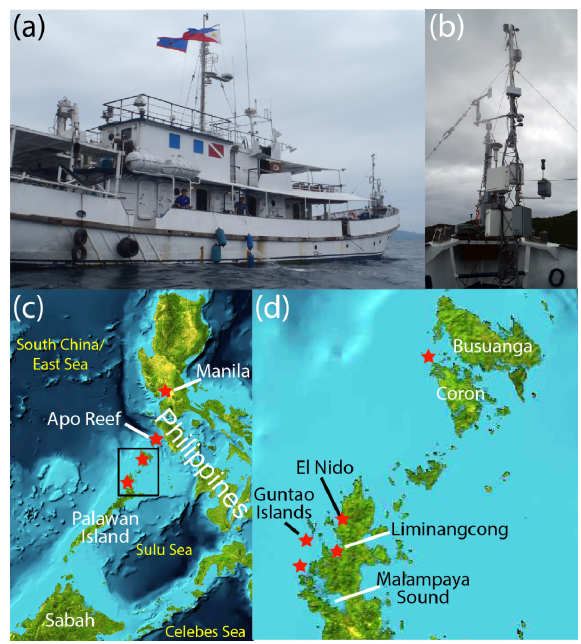
Figure 1. (a) The M/Y Vasco ; (b) bow flux tower during the cruise. (c) Map of cruise area, stars mark key areas of sampling. (d) En- largement of the northern Palawan/Coron sampling